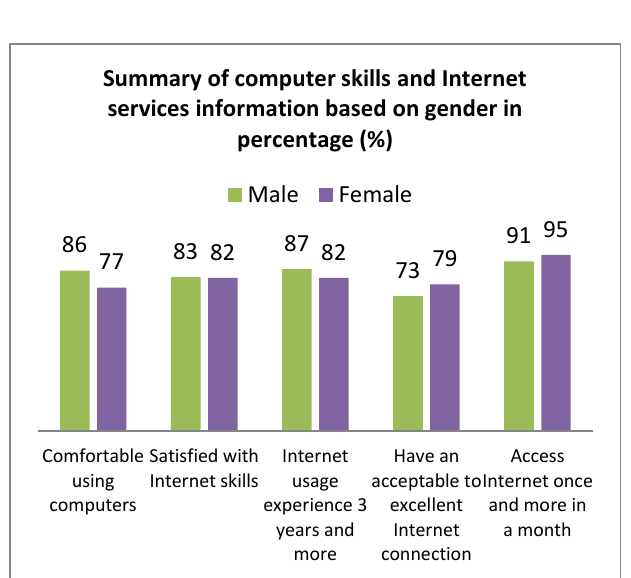
Figure 6. Summary of computer skills and Internet services information based on gender in percentage (%)